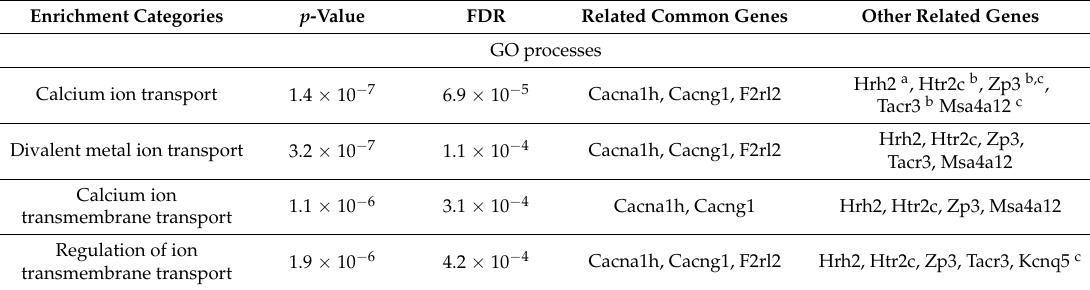
Table 8. MetaCore enrichment analysis comparing DE genes in the three groups (CvN, CvA,